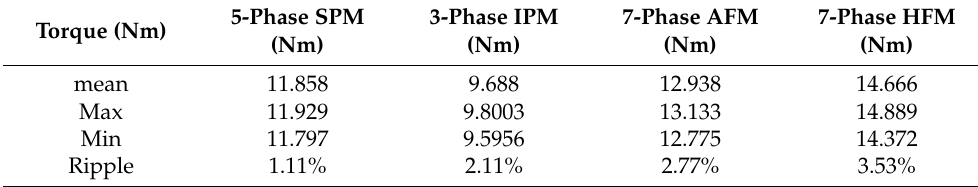
Table 3. On-load torque characteristics of the four machines.